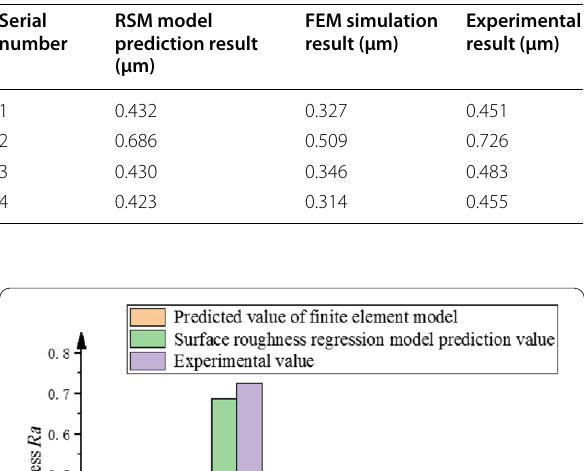
Table 10 Comparison between experimental result and simulation result